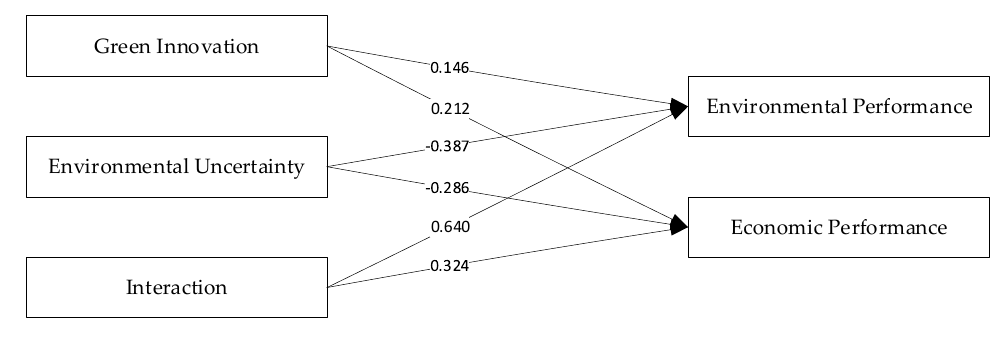
Figure 3. Path analysis.